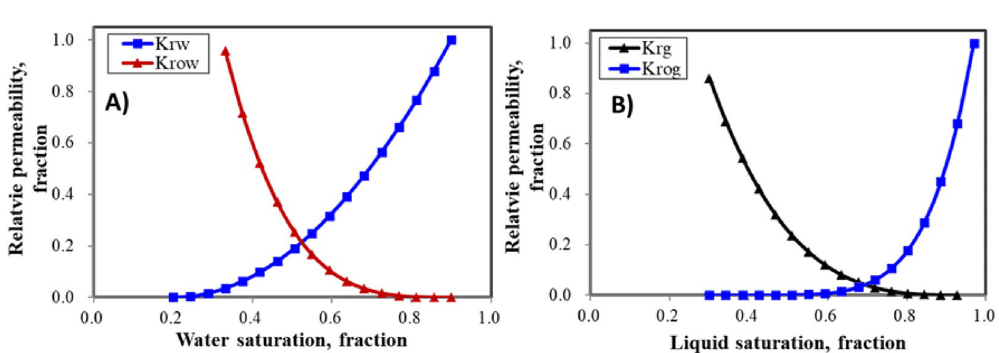
Figure 6. Relative permeability curves. ( A ) Water-oil relative permeability curve. ( B ) Liquid-gas relative permeability